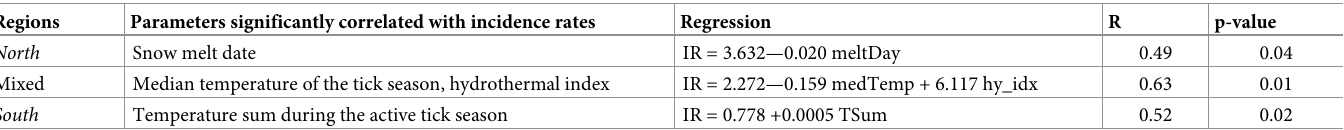
Table 3. The results of multiple linear regression analysis for different clusters of regions. The regions with one removed outlier are written in italic. Regions Parameters significantly correlated with incidence